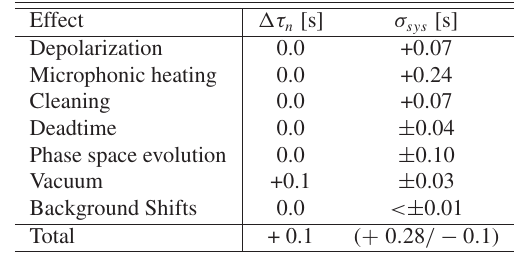
Table 2. Systematic corrections and their associated uncer- tainties in the 2017 UCN τ data are listed. The only correction applied to this data is due to residual gas up-scattering. The total uncertainty is the uncorrelated sum of the uncertainties of all